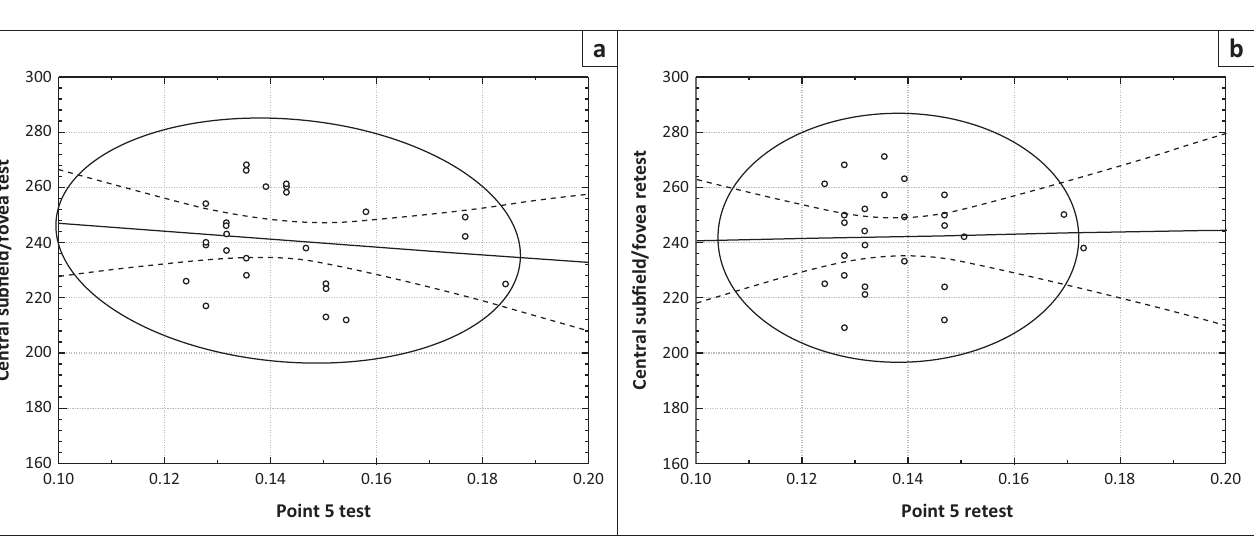
FIGURE 8: Scatter plots for (a) test and (b) retest measurements of oscillatory threshold ( µ m) versus ocular coherence tomography ( µ m) for the sample ( n =